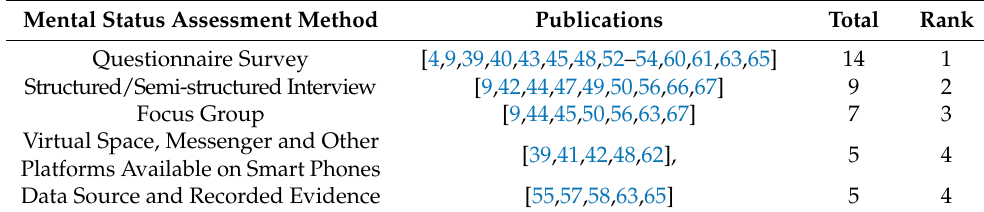
Table 3. Mental status assessment method.